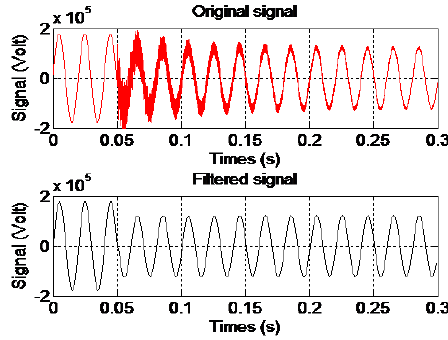
Fig. 4: Signal voltage: original and (cid:28)ltered signals.